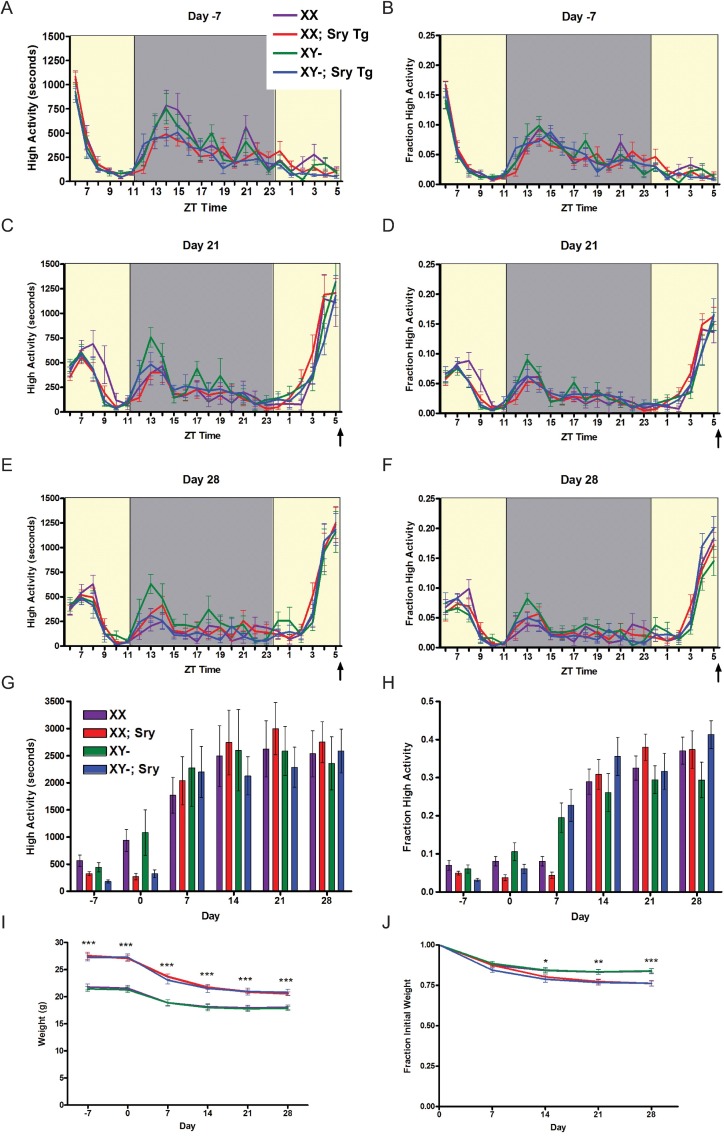
Sex chromosome copy number does not alter food anticipatory activity.(A) Mean (+/- SEM) seconds of high activity behaviors seven days prior to initiating scheduled CR feeding in XX (purple), XX; Sry Tg+ (red), XY- (green), and XY-; Sry Tg+ (blue) mice. (B) Normalized mean high activity of data shown in A. Mean seconds of high activity behaviors after (C) three or (E) four weeks of timed CR feeding. (D,F) Normalized mean high activity of data shown in E and F, respectively. (G) Mean seconds of high activity data in the three hours preceding scheduled feeding across 28 days of the experiment. (H) Mean normalized high activity data in the three hours preceding scheduled mealtime. (I) Mean body weights for males and female mice one week pre-CR and four weeks on a CR diet. (J) Percentage weight loss calculated by normalizing to day 0. * P<0.05, **P<0.01, *** P<0.0001, One-way ANOVA, Tukey-Kramer multiple comparisons. n = 9 for XX mice, n = 12 for XX;Sry Tg mice, n = 11 for XY- mice, and n = 11 for XY-;Sry Tg mice. The arrow indicated the time of expected food delivery (ZT6).